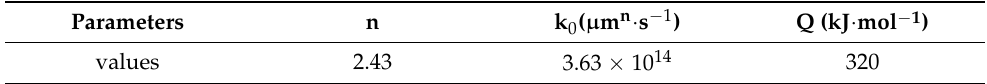
Table 3. Material parameters related with the prediction of grain size.